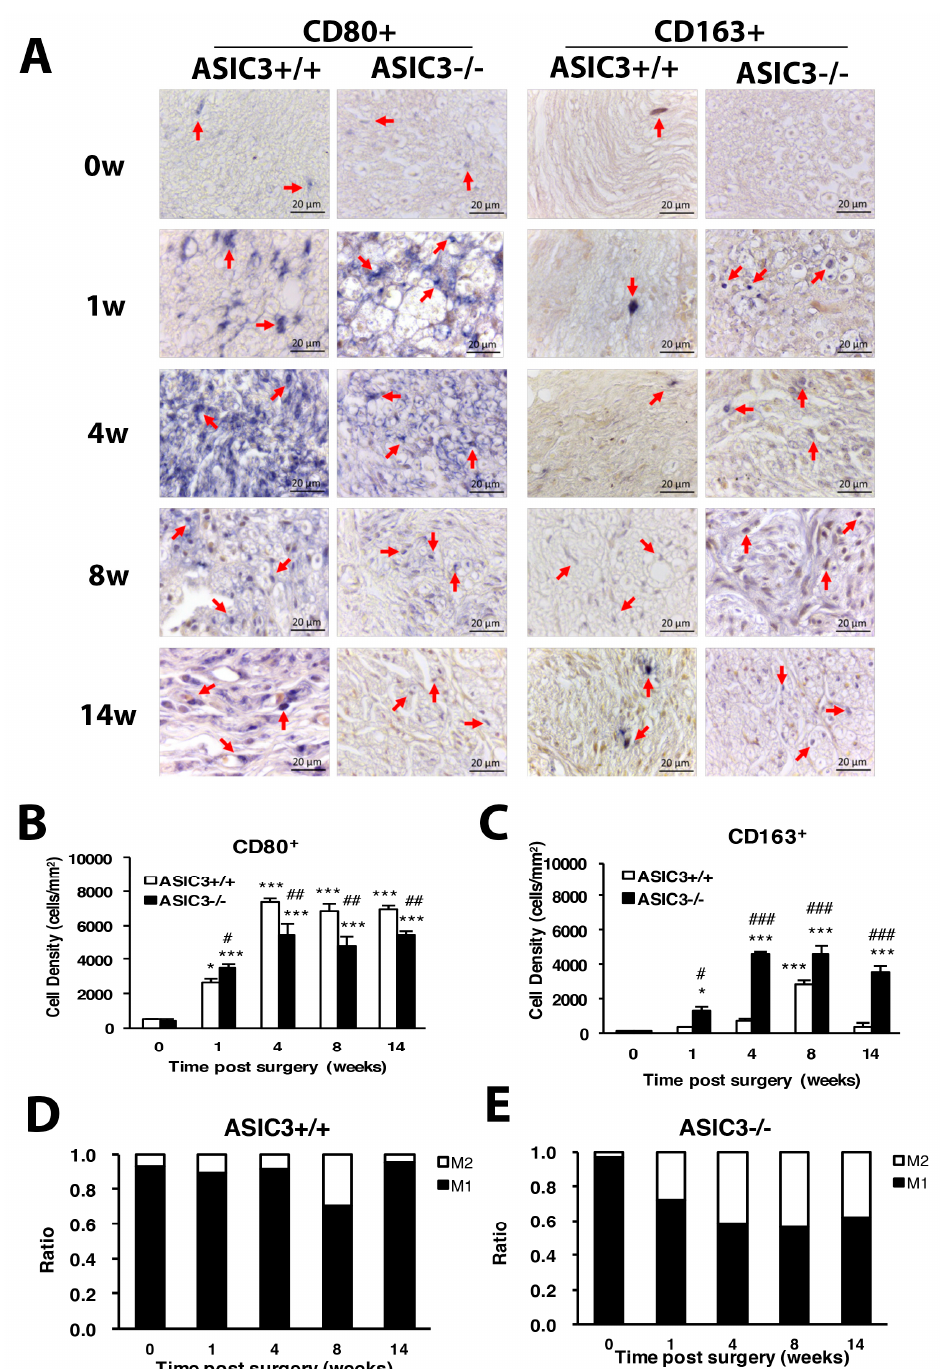
Figure 9. ASIC3 deletion increases M2 macrophage number but reduces M1 macrophage number. The sciatic nerves from the ipsilateral side of ASIC3 +/+ or ASIC3 − / − mice were excised before (0 w) or at 1, 4, 8 and 14 w after CCI surgery, then fixed and cross-sectioned, followed by incubation with anti-CD80 (CD80 + for M1 macrophages) or anti-CD163 (CD163 + for M2 macrophages) antibodies. Representative sections showing macrophages in the sciatic nerve ( A ). Scale bar is 20 µ m. Arrows indicate macrophages. ( B , C ) Cell density of CD80 + (M1) ( B ) or CD163 + (M2) ( C ) macrophages. Total cell number was calculated from regions of 1 mm 2 to obtain the cell density (n = 3 mice). # p < 0.05; ## p < 0.01; ### p < 0.001 for ASIC3 − / − vs. ASIC3 +/+ by two-way ANOVA with post-hoc Bonferroni test. ( D , E ) M1 and M2 ratio in ASI3 +/+ ( D ) and ASIC3 − / − ( E ) sciatic nerve.